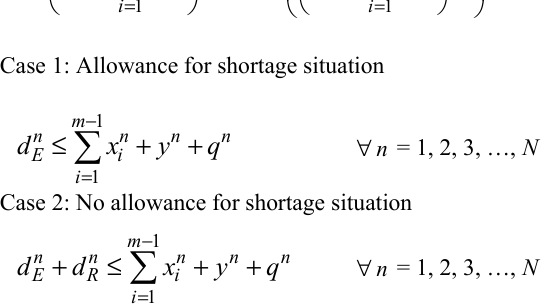
Inventory State at Blood stock of the hospital